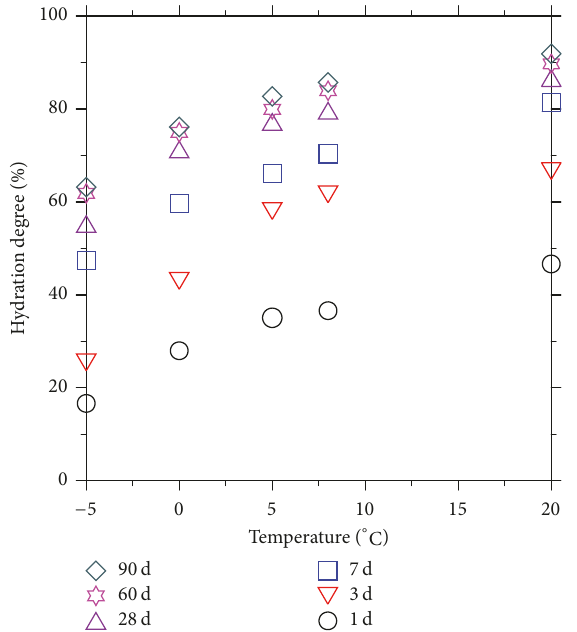
Figure 6: Degree of hydration development over curing temperature variation.